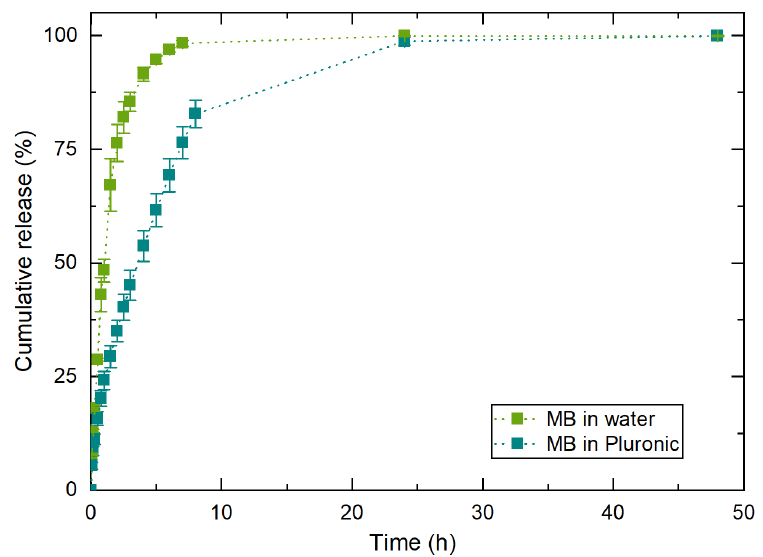
Figure 10. Control experiments of MB release profiles from water and the selected Pluronic hydrogel: F127/F68 18/2 wt.% at 37 °C. The results are expressed as average ± standard deviation for three independent experiments.